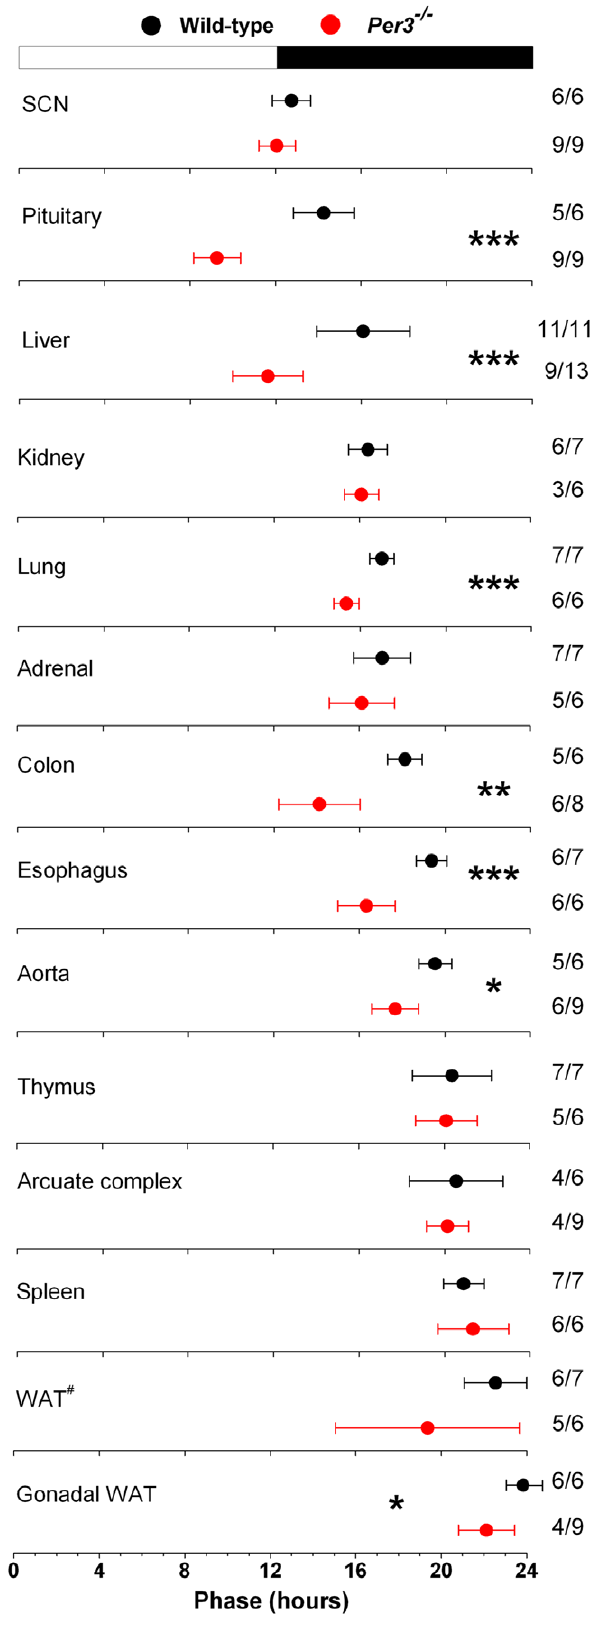
Figure 2. Altered circadian organization in Per3 2 / 2 mice. Bioluminescence was recorded from tissue explants prepared from male wild-type (black circles) and Per3 2 / 2 (red circles) mice maintained in 12L:12D. The mean phases ( 6 SD) were determined from the peaks of PER2::LUC expression during the interval between 12 h and 36 h in culture and were plotted relative to the time of last lights-on, where 0 h is lights on and 12 h is lights off (black and white bar at top). The sample size is shown (number of rhythmic tissues/number of tissues tested). WAT # : white adipose tissue surrounding the adrenal gland. * p , 0.05; ** p , 0.01; *** p ,